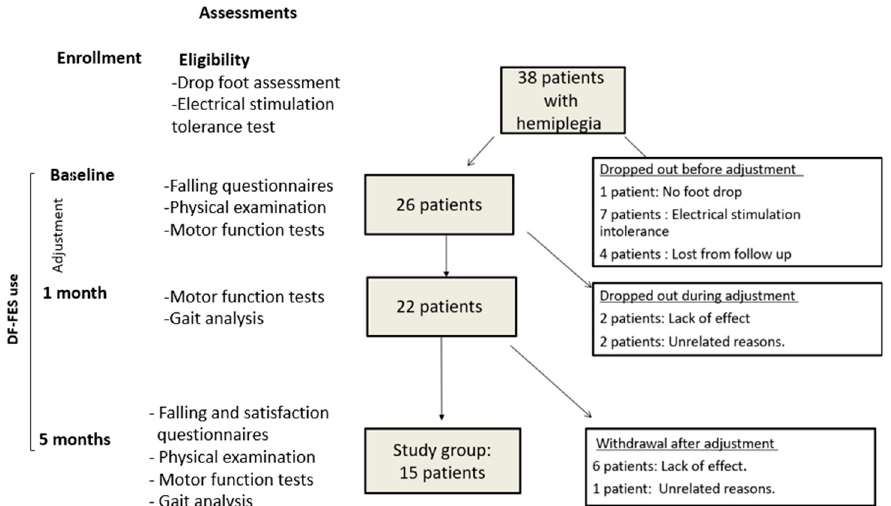
Figure 1. Flow chart and study design.